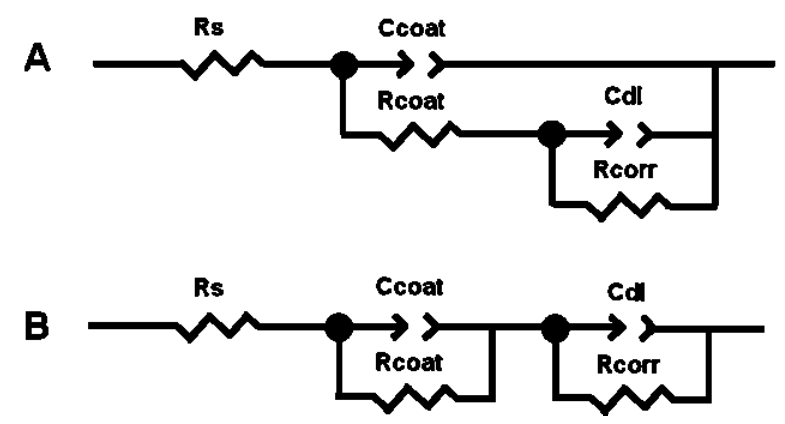
Figure 16. Electrical Equivalent Circuits (EECs) used to analyze the experimental electrochemical impedance data. ( A ) Parallel Maxwell forms; ( B ) Series Voigt forms [38].